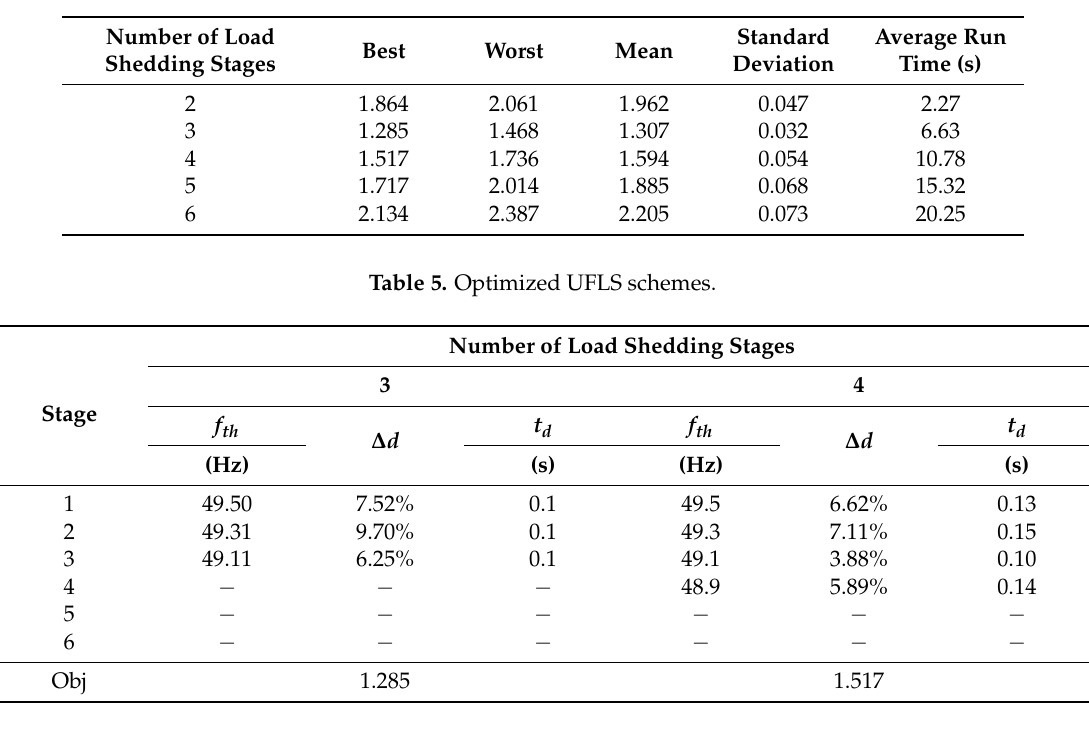
Table 4. Statistics of the optimization results for the UFLS design.